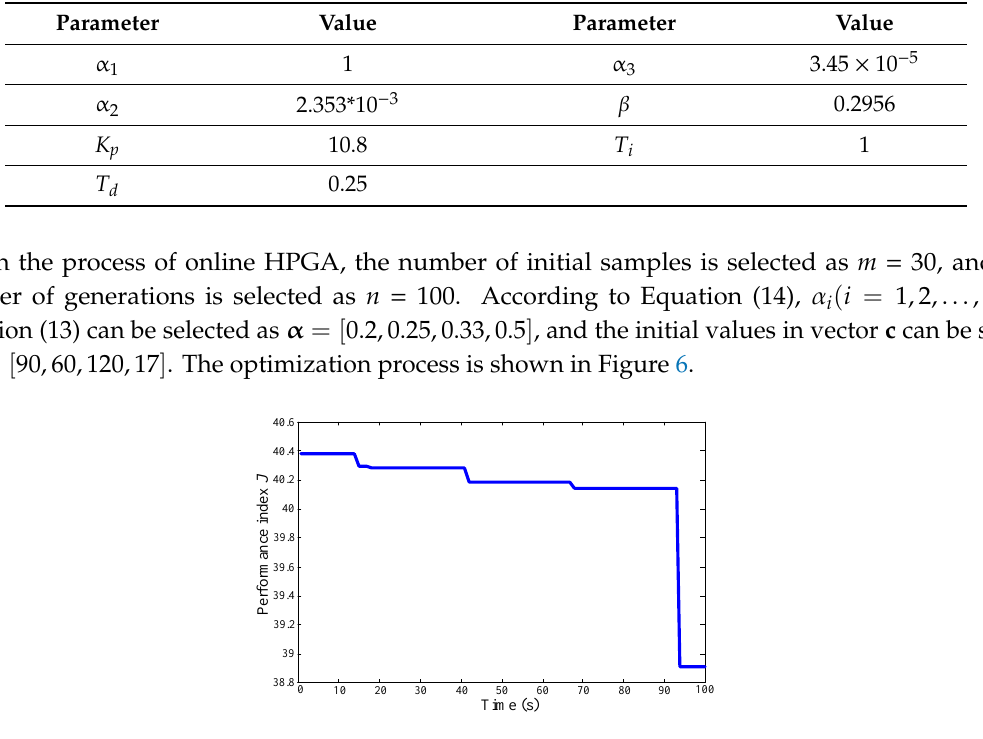
Figure 7. Variation of the grating ruler position (the proposed method in the blue line, PID controller in the red line, and the desired sine signal in the green line). During the voyage of a ship, the load fluctuation and the operation condition variations will result in model uncertainty. Hence, the sine signal tracking test based on the model with uncertainty is performed. In the simulation, a 20% load change was introduced into the system, and the uncertainties imposed in the model are listed as follows: 1